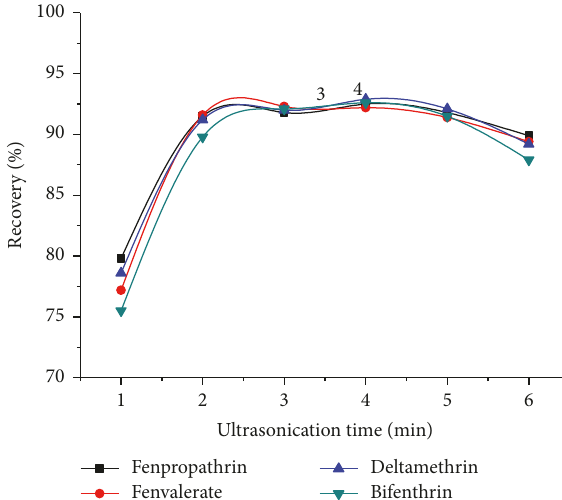
Figure 4: Effect of pH. extraction conditions: sample volume, 50.0 mL spiked with 100 ng mL −1 of four pyrethroids; magnetic nanoparticles (MNPs), 60 mg; ultrasonication time, 2 min; eluent solvent, 2 mL of acetonitrile /acetic acid (9:1, v/v).